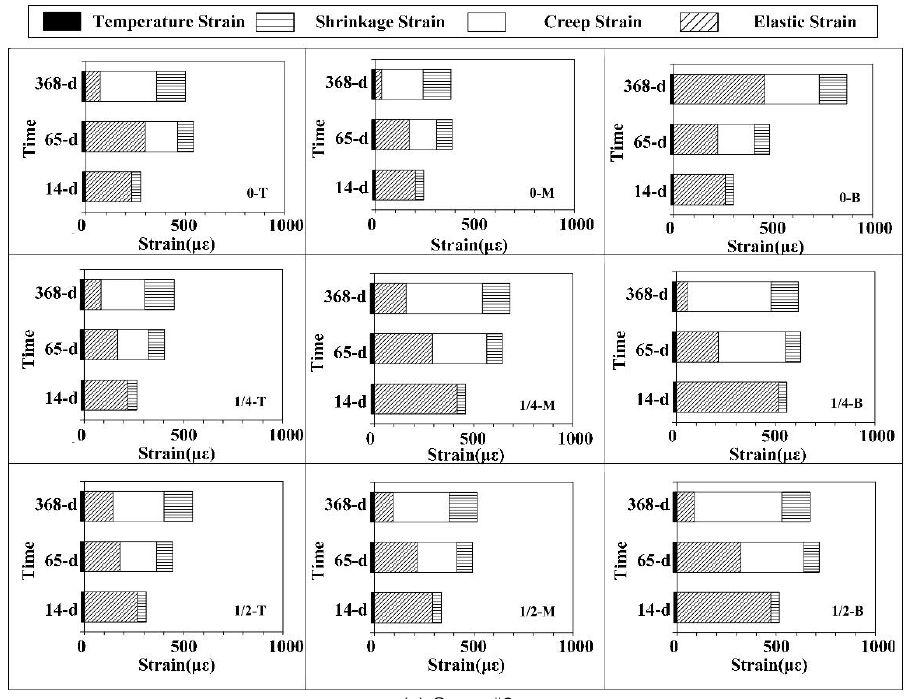
Figure 8. Components of the total strain.